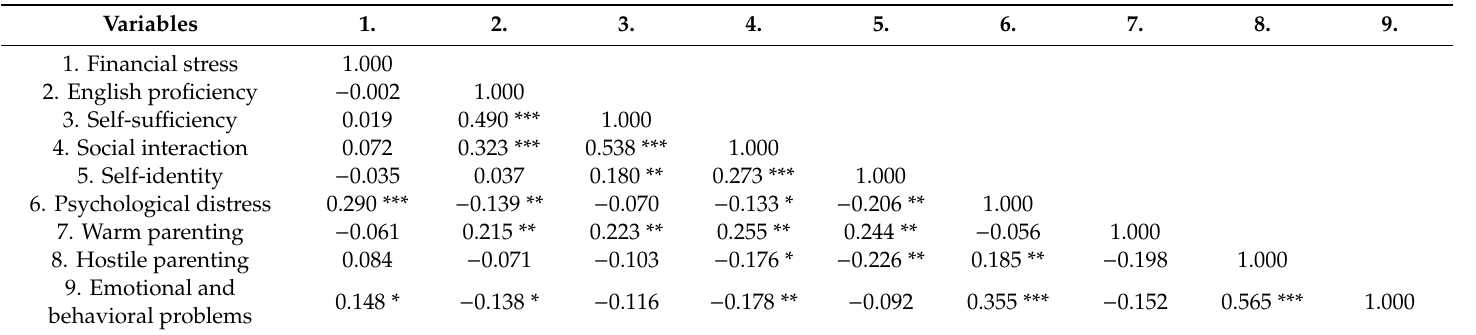
Table A2. Correlations among all constructs.